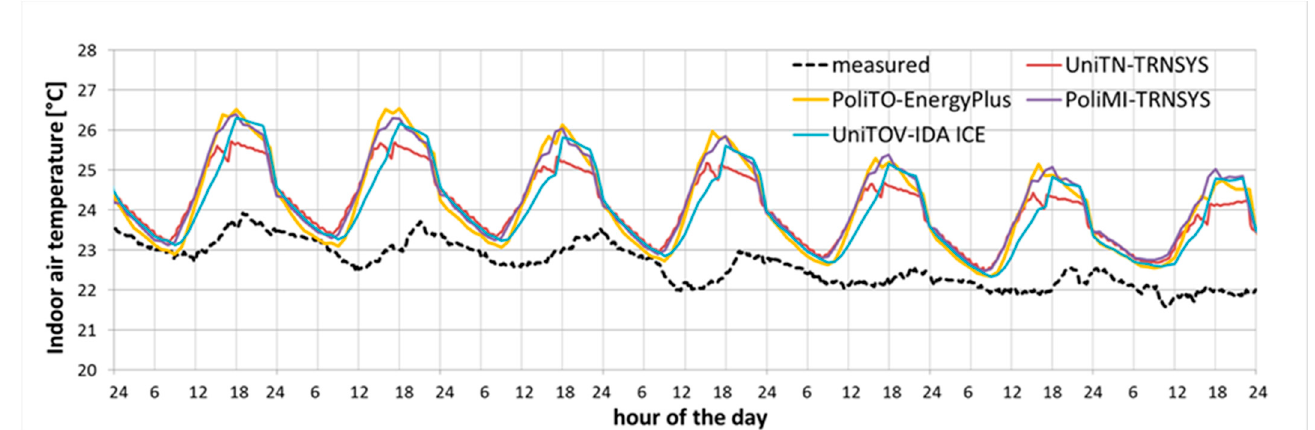
Figure 3. Baseline model simulations compared to measures for the 3rd week of October 2017.